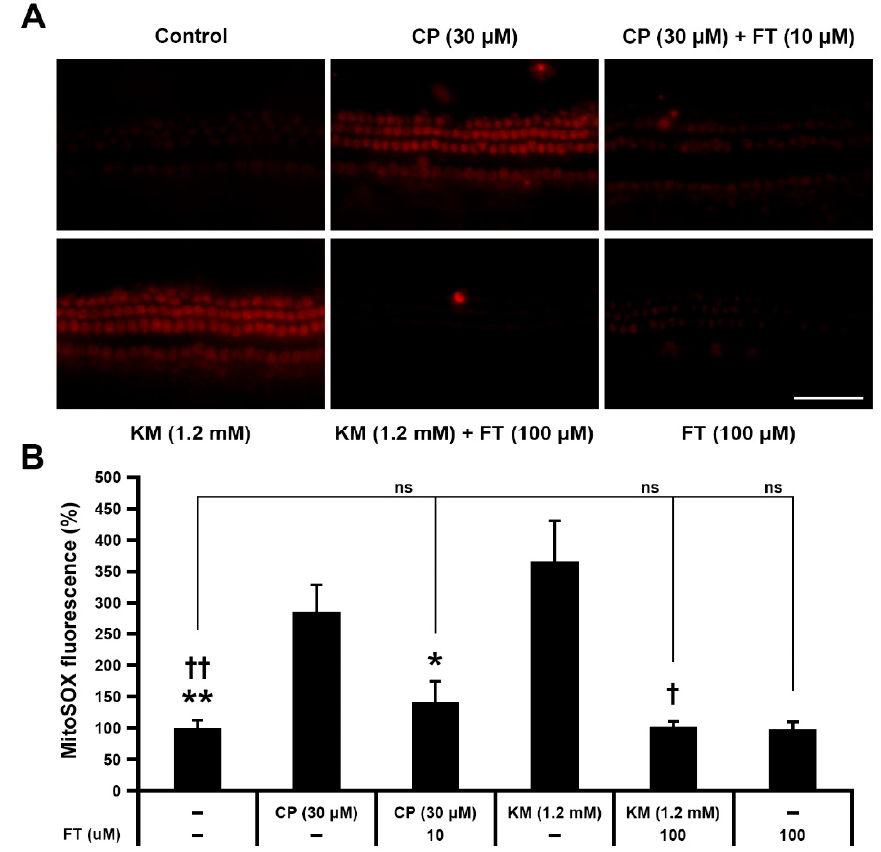
Figure 3. FT prevents mitochondrial ROS accumulation in hair cells of mouse cochlear explants. ( A ) Images of MitoSOX Red immunostaining in Control, CP, CP + FT, KM, KM + FT, and FT groups after 24 h of incubation ( n = 9, each). Images were acquired from the mid region of the organ of Corti. ( B ) Comparison of red signal intensity ratios between each group. All groups contained 27 mice. Data are shown as mean ± SD. *, † p < 0.05 and **, †† p < 0.01 compared with the CP group. CP: cisplatin, KM: kanamycin, FT: fursultiamine, ns: not significant. Scale bar, 50 μ m.